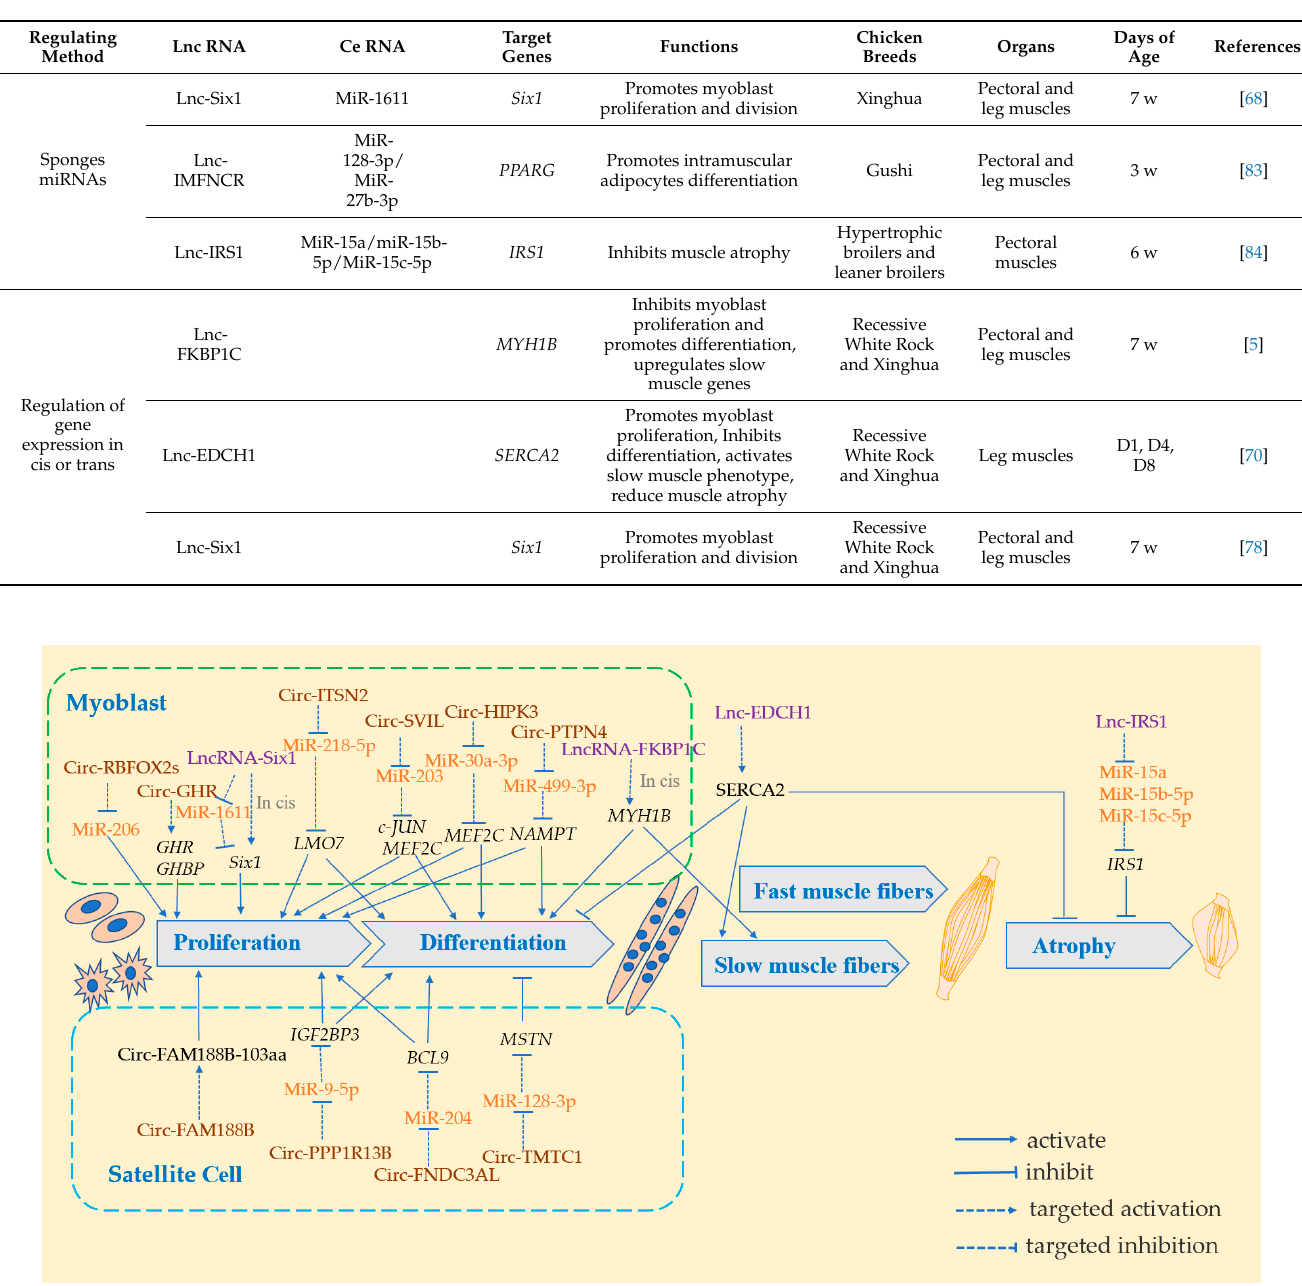
Table 3. Species and functions of LncRNAs involved in skeletal muscle of domestic chicken.